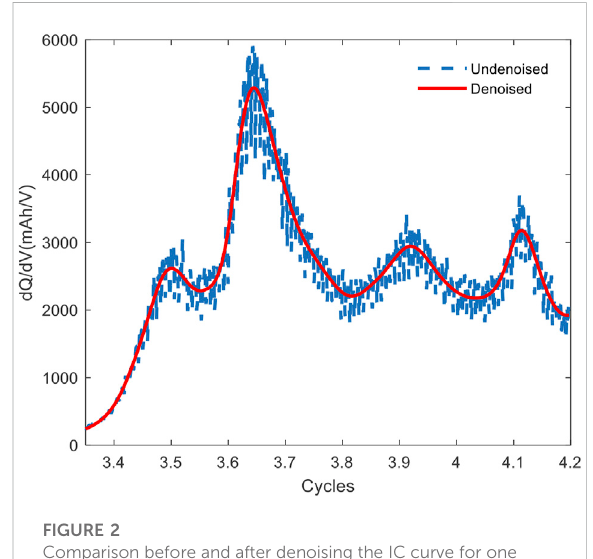
FIGURE 2 Comparison before and after denoising the IC curve for one cycle of charging and discharging.